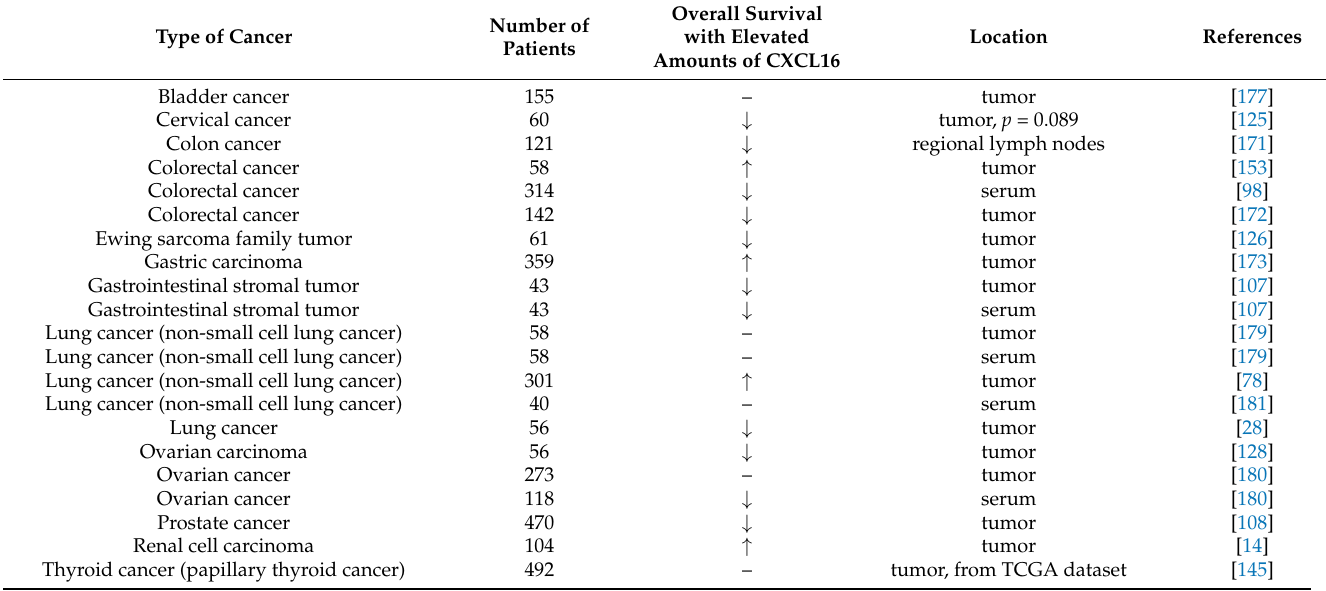
Table 3. Overall survival of patients with high tumor or serum CXCL16 expression.